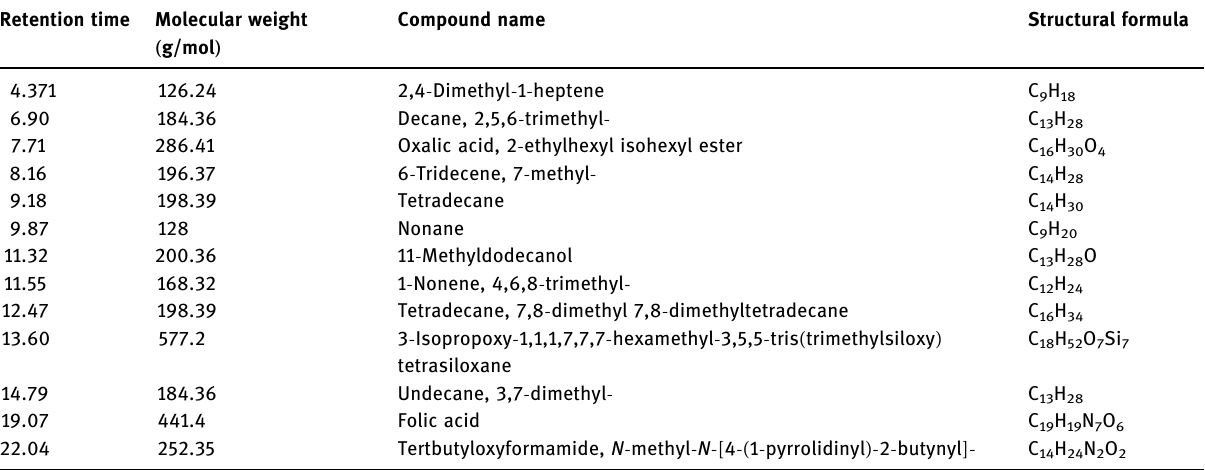
Table 1: Phytochemical compounds identi fi ed in B. hispanica bark extract Retention time Molecular weight ( g/mol